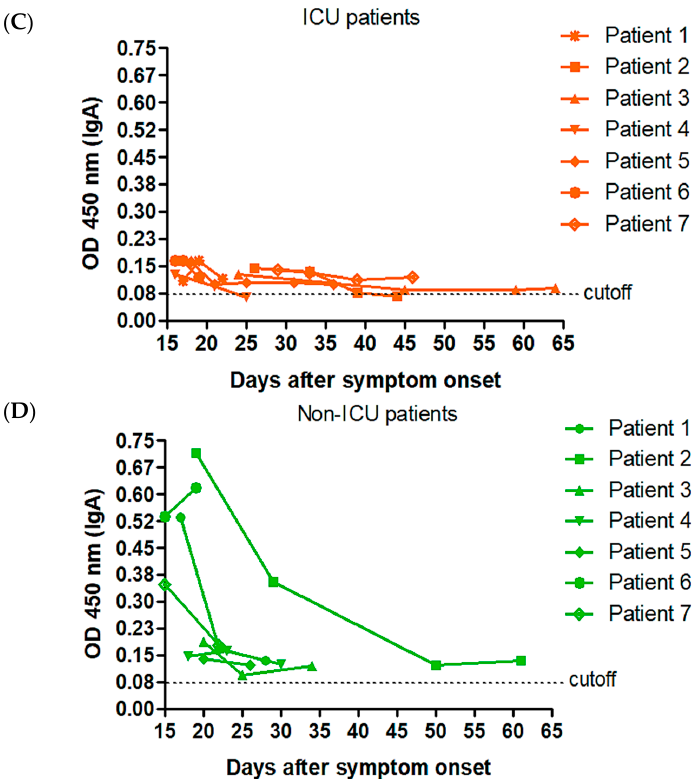
Figure 3. Kinetics of IgM ( A , B ) and IgA ( C , D ) responses to SARS-CoV-2 in ICU ( n = 7) and non-ICU patients ( n = 7) with no medical history of hematological malignancies and hospitalized for at least two weeks. By using the in-house cell-based ELISA, the antibody response was studied in ICU cases ( A – C ), from day 15 after symptom onset. A similar analysis was performed in non-ICU cases ( B – D ).